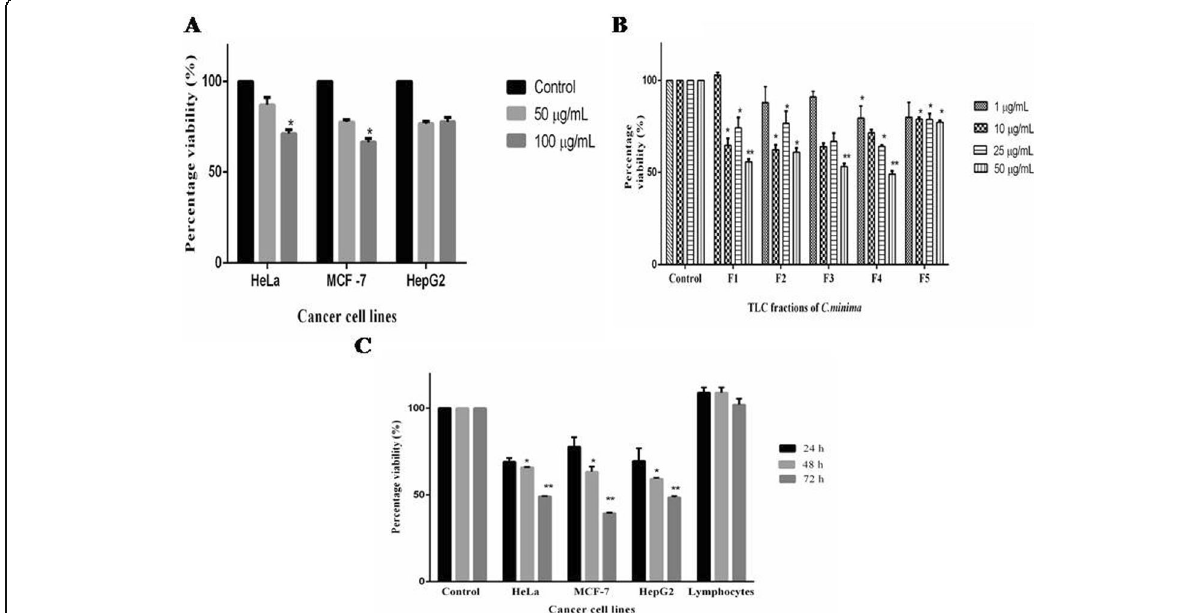
Fig. 4 Effect of C. minima extract and CF4 fraction on human cancer cell lines. a Percentage viability of HeLa, MCF-7 and HepG2 cells treated with C. minima . b Effect of TLC fractions of C. minima on MCF-7 cells for 48 h. c Effect of CF4 on HeLa, MCF-7, Hep G2 and lymphocyte cells for 24, 48 and 72 h. The values are expressed as mean ± SE. An asterisk denotes significance at p < 0.05 and two asterisks denotes significance at p <